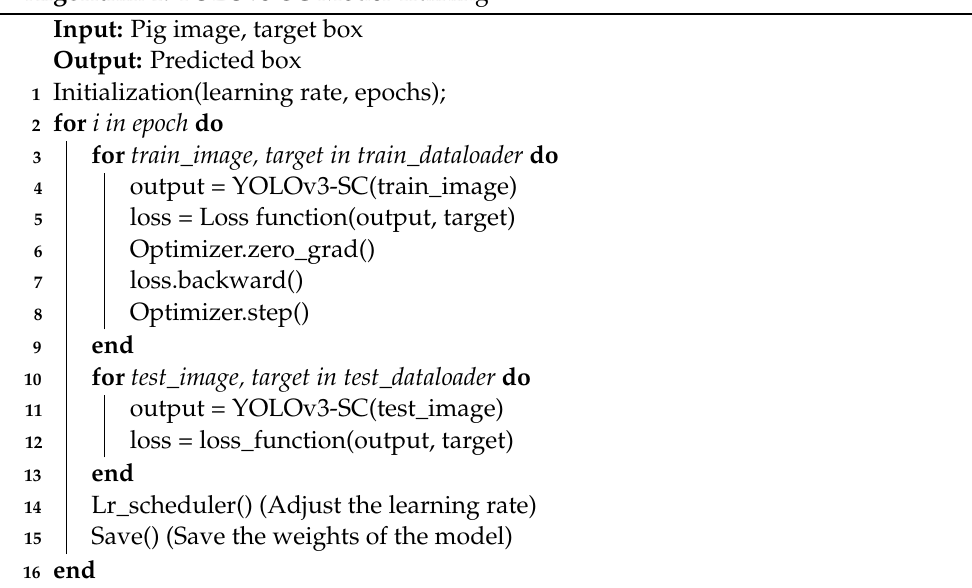
Algorithm 1: YOLOv3-SC Model